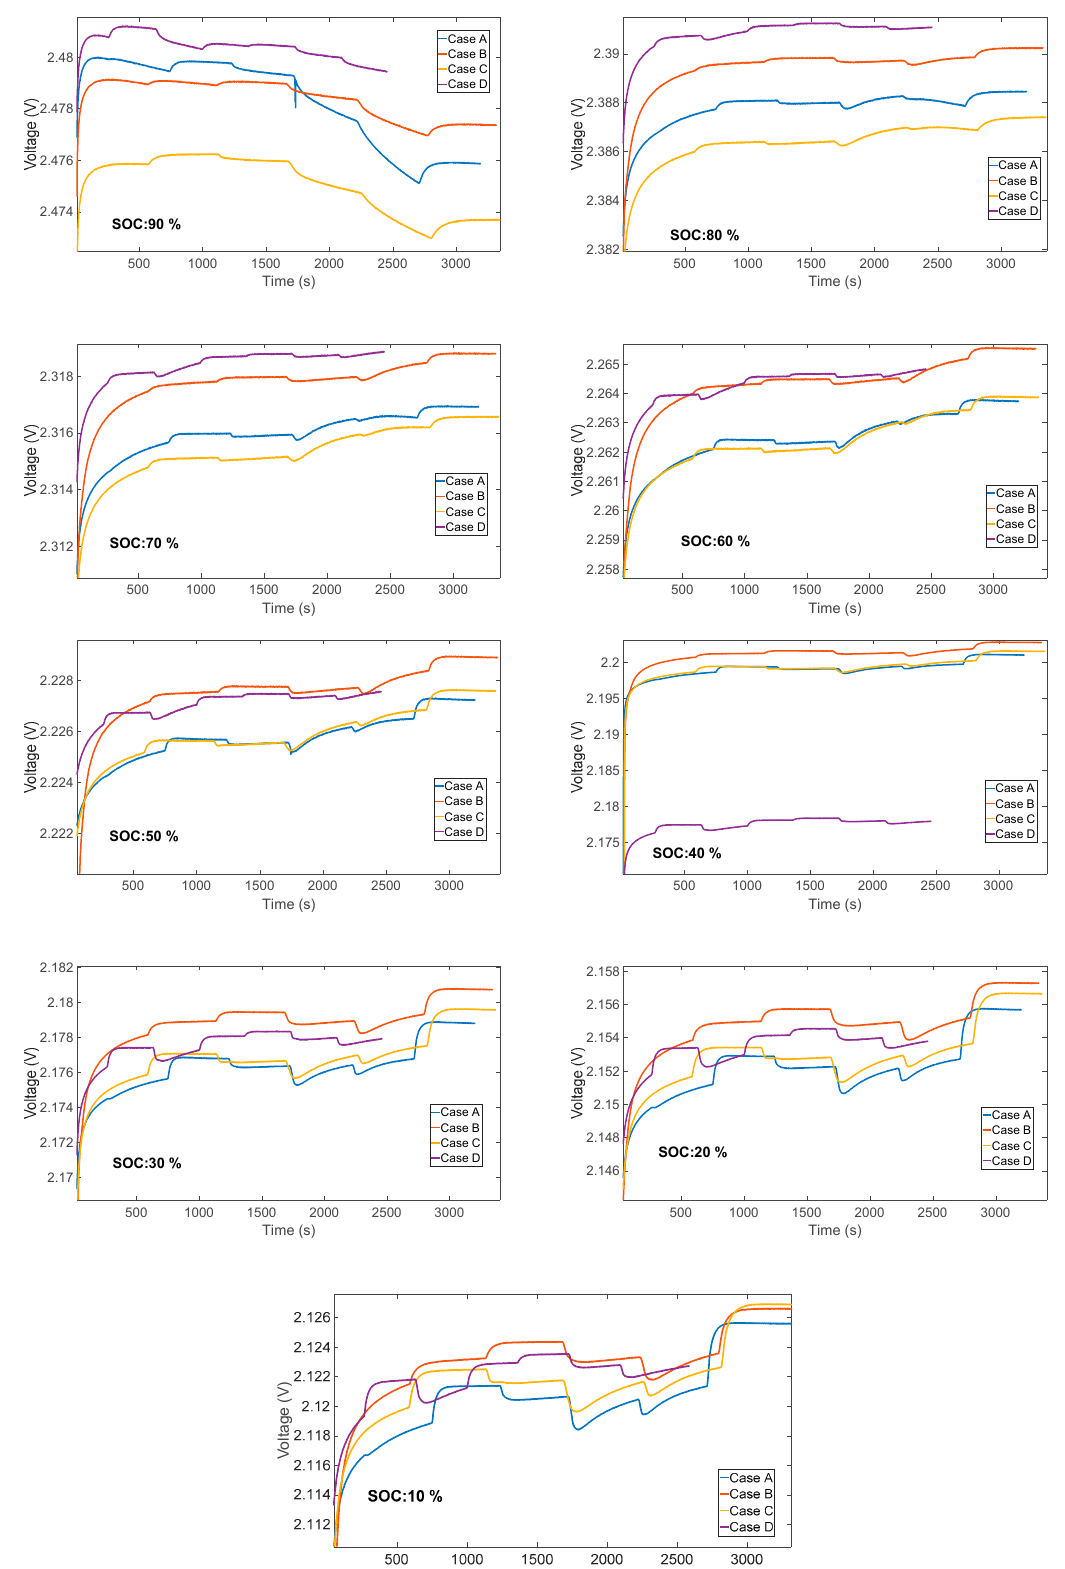
Figure 3. Voltage variations during four cases at various state of charge (SOC).